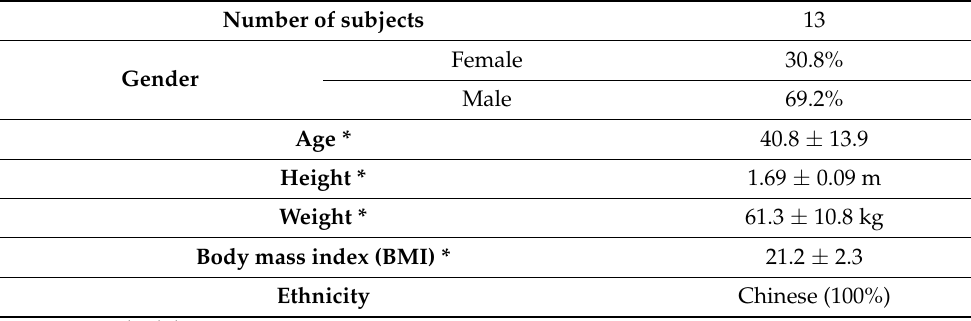
Table 2. Background information of the subjects for glycemic index trial.